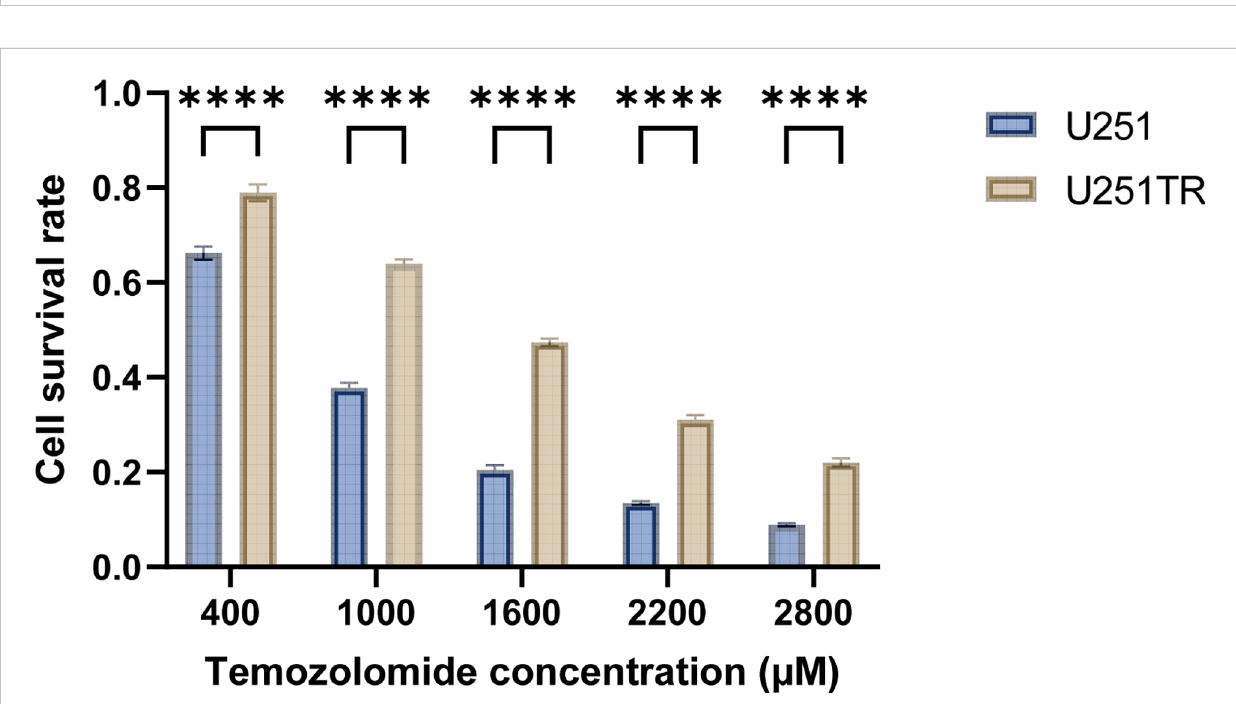
FIGURE 6 The blue color indicates the U251 group, and the coffee color indicates the U251TR group. The results of temozolomide toxicity experiments revealed that the survival rate of U251 was signi fi cantly lower than that of U251TR at various temozolomide concentrations